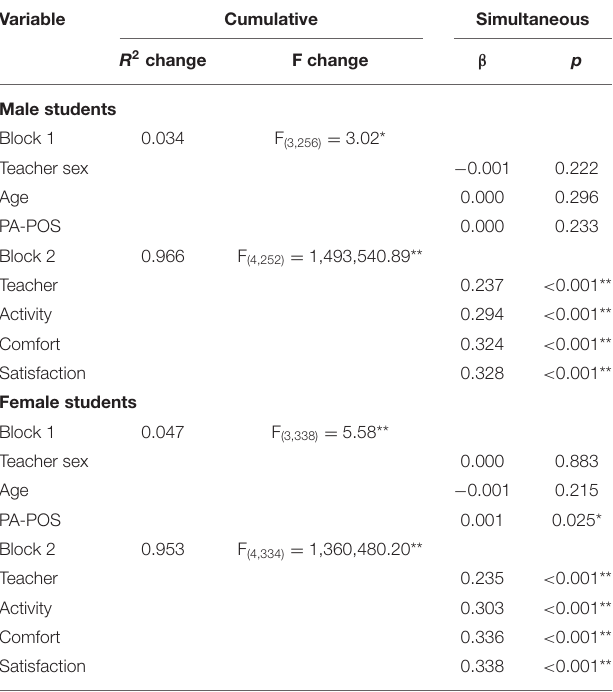
TABLE 2 | Hierarchical multiple regression predicting PE